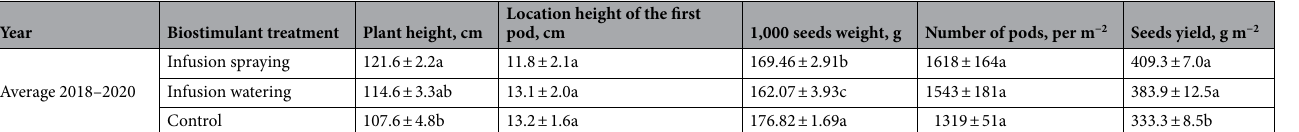
Biostimulant treatment Plant height, cm